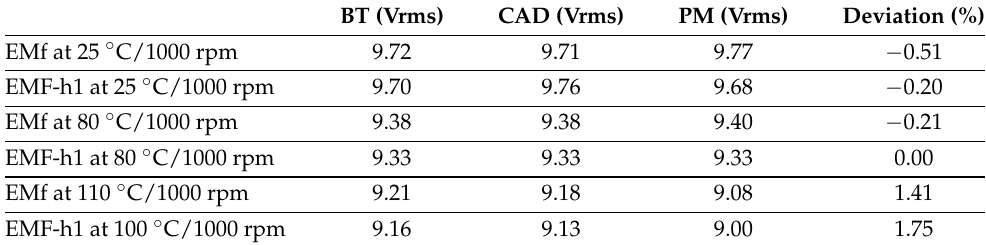
Table A1. Comparison results for no load scenarios.